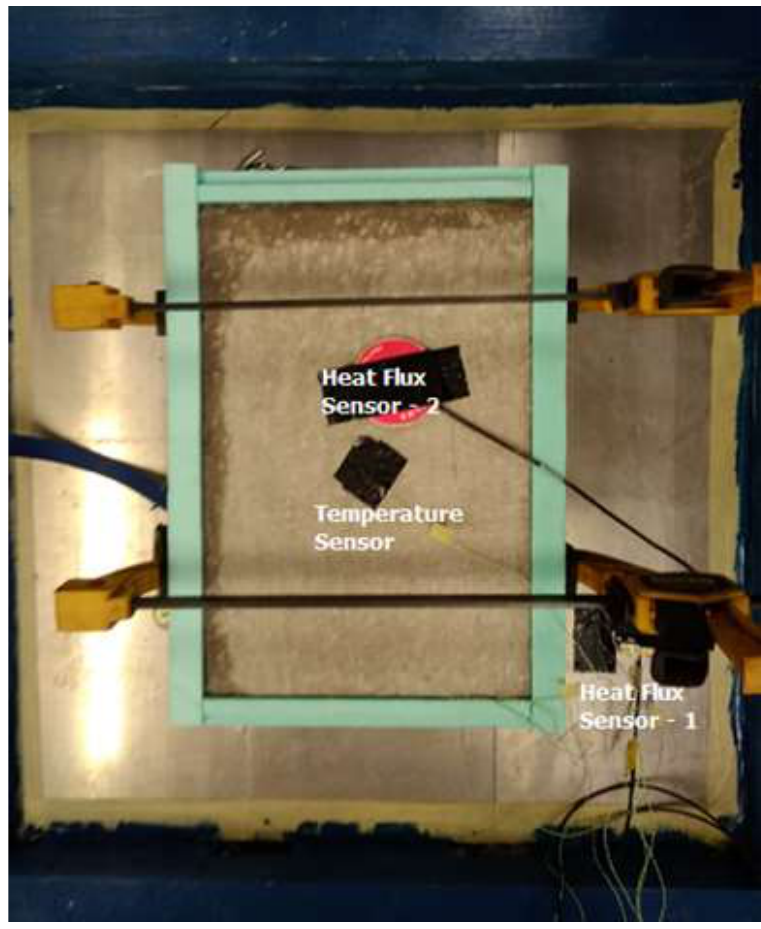
Figure 6. Heat flux pads placement at concrete sample top and hot plate.